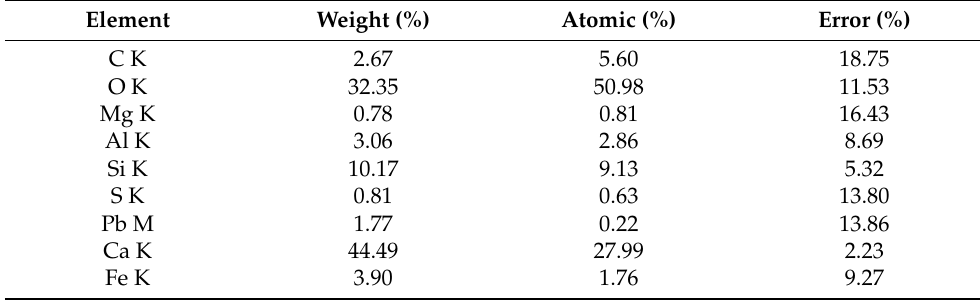
Figure 8. ( a ) 0.4% Pb 2 O 3 (S4), ( b ) 0.6% Pb 2 O 3 (S5), ( c ) Plain cement (PC). Table 4. EDAX results, 0.4% Pb 2 O 3